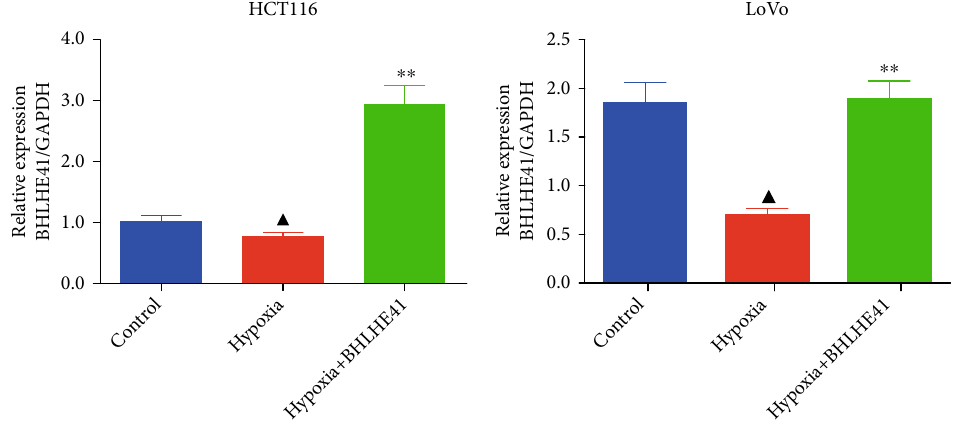
Figure 2: Expression of BHLHE41 mRNA in HCT116 and Lovo cells. All experiments have been performed in triplicate, and data were expressed as mean ± SD . ∗∗ P < 0 : 01 vs. hypoxia; ▲ P < 0 : 5 , ▲▲ P < 0 : 01 vs.